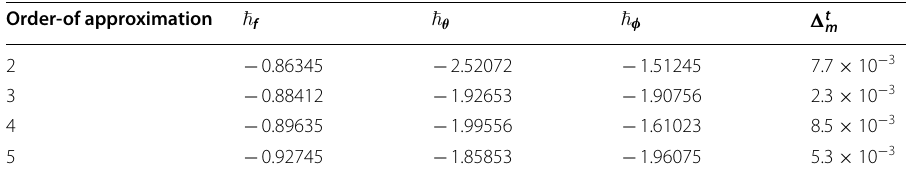
Table 2 Show the optimal auxiliary parameter values at various approximation values